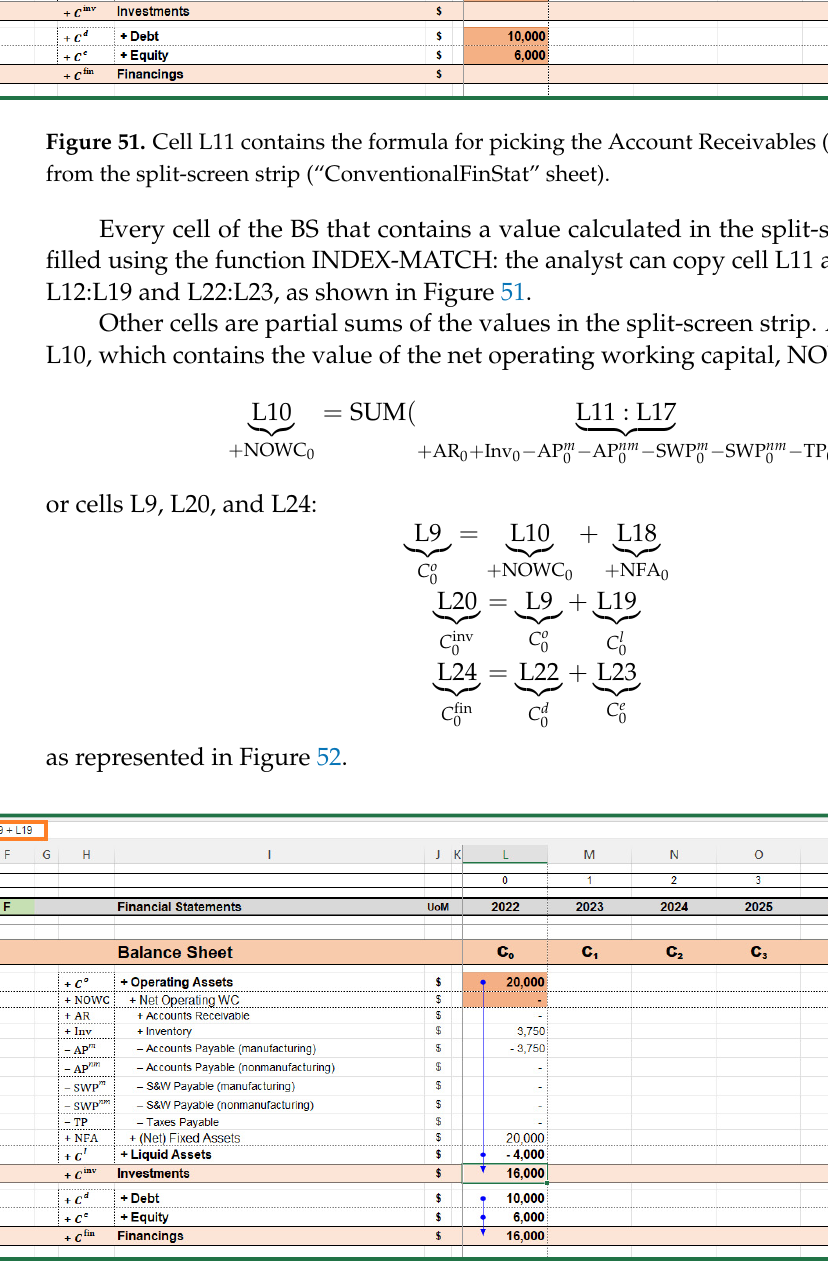
Figure 52. Cell L20 contains the formula fur summarizing C o and C l , which determine C inv (“ConventionalFinStat” sheet).